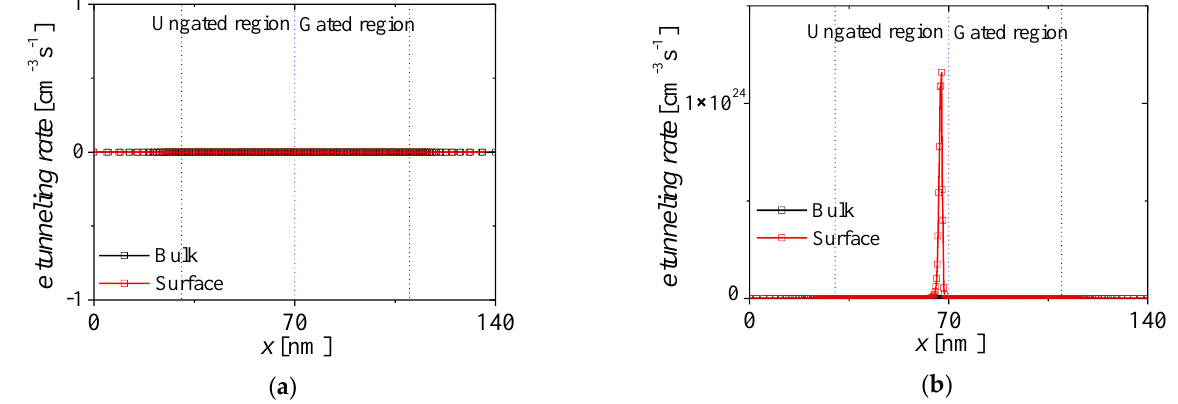
Figure 5. Electron tunneling rates at two cases of V DS on bulk and surface regions. ( a ) V DS = 0 V (initial state) and ( b ) V DS = 1 V. (initial state) and ( b ) V DS = 1 V.